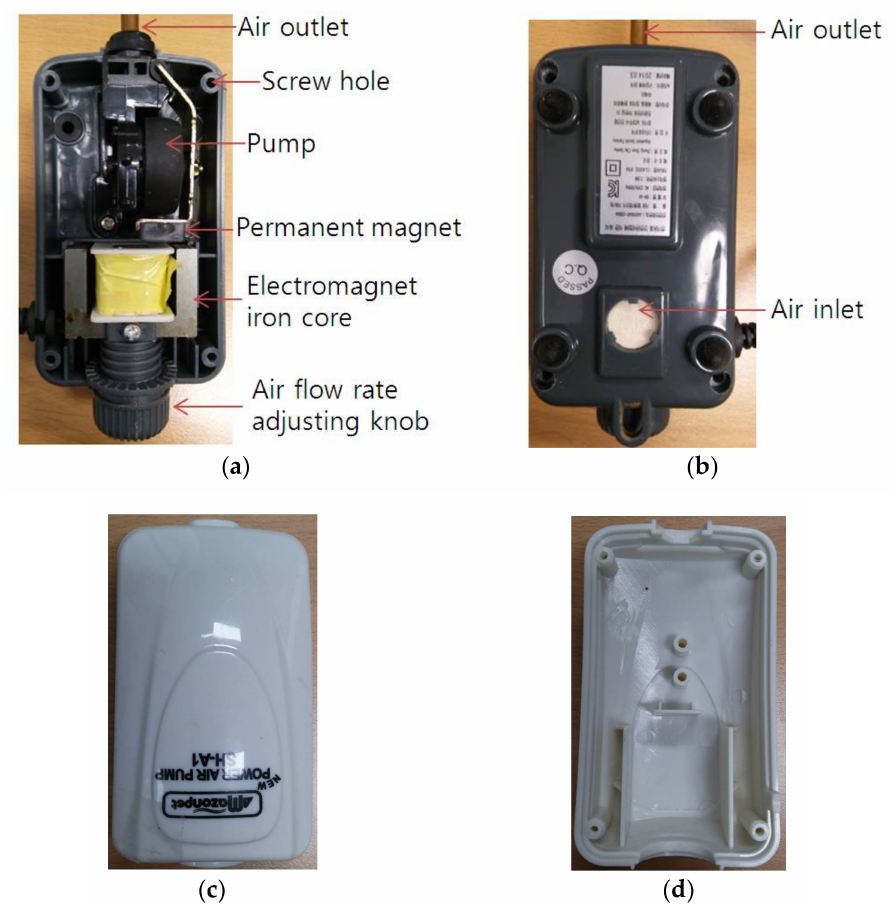
Figure 5. Inside and outside of air compressor and cover: ( a ) Inside of air compressor; ( b ) Bottom of air compressor; ( c ) Outside of air compressor cover; ( d ) Inside of air compressor